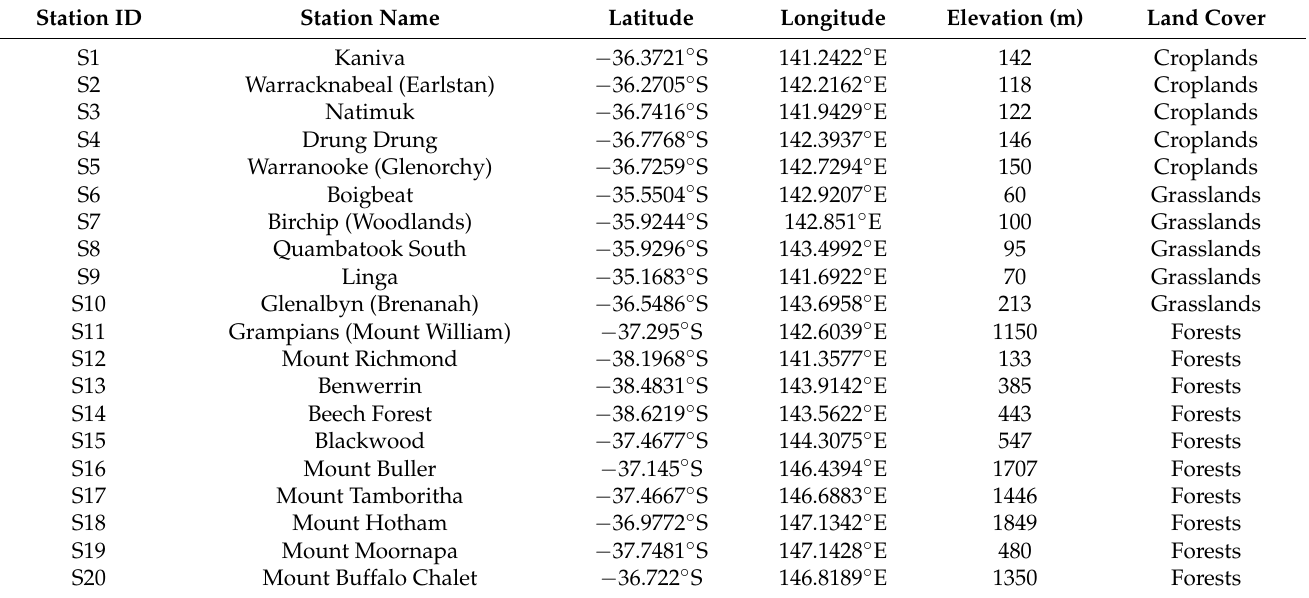
Table 2. Details of the weather stations and corresponding land cover